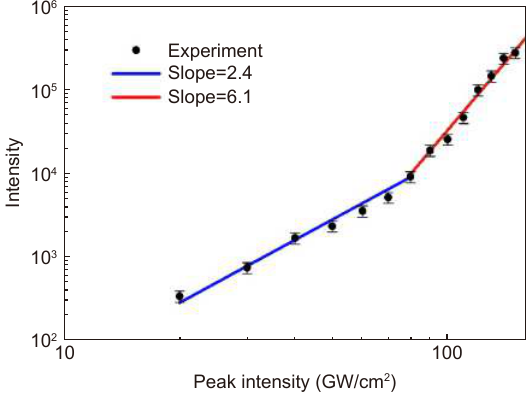
Fig. 17 | The intensity of the emission signal from the cavity versus pump intensity ( τ = 200 fs). Above 80 GW cm –2 , the slope increase infers gain within the